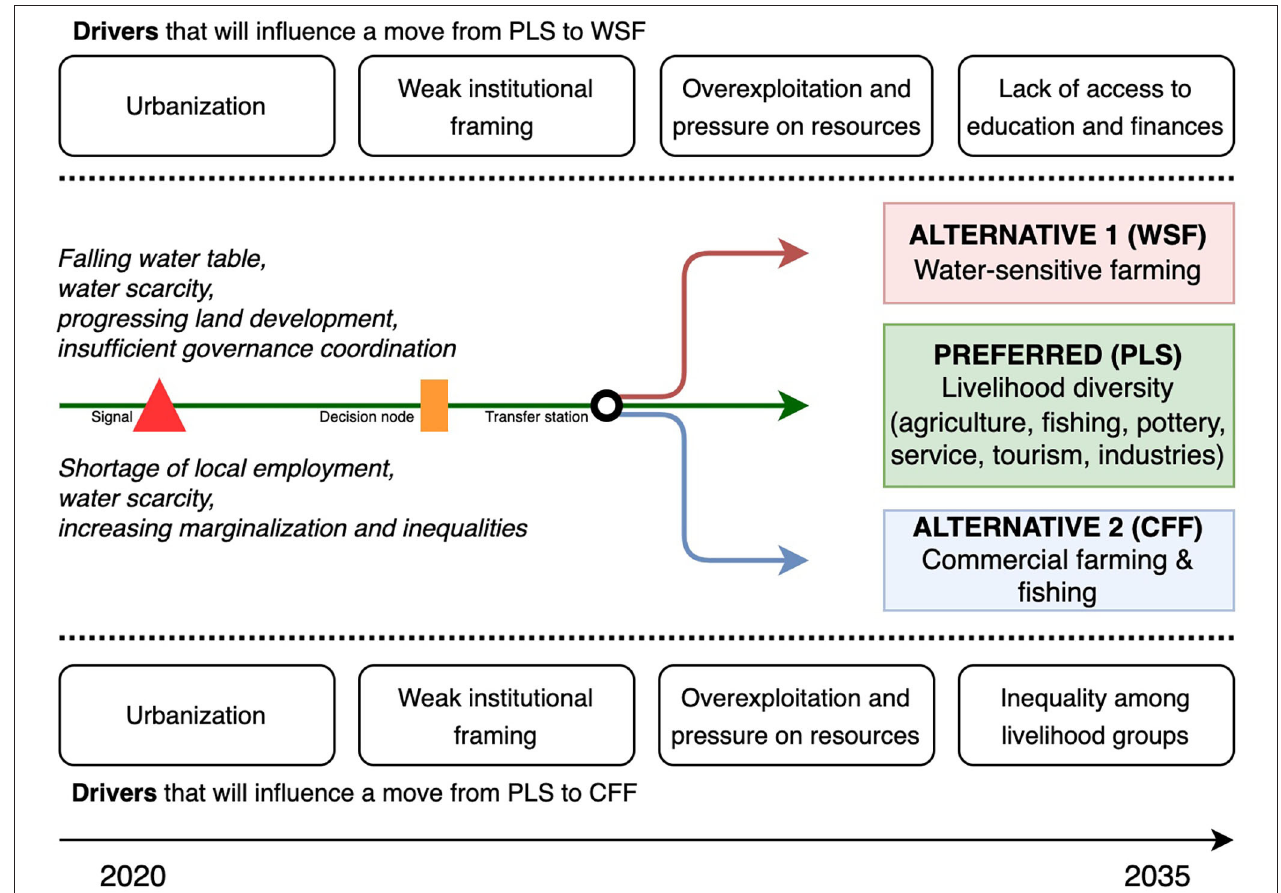
FIGURE 5 | Experts’ view on future livelihood